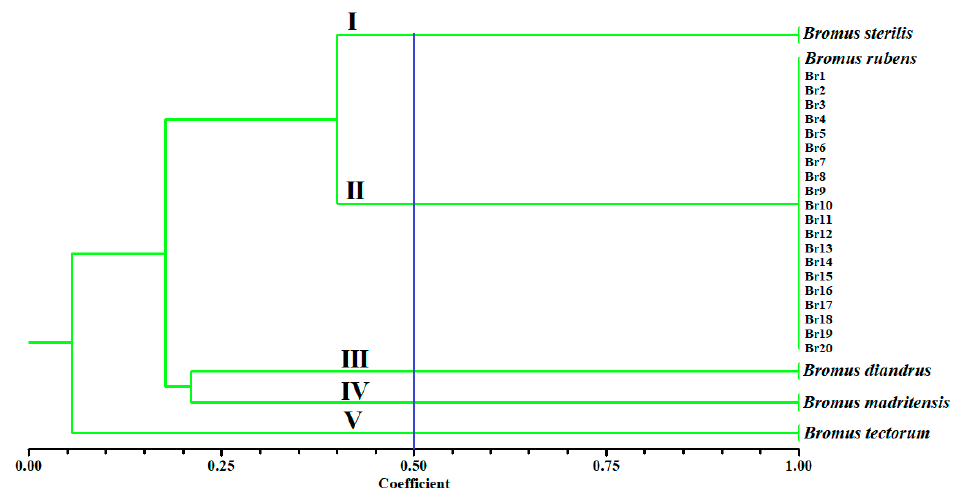
Figure 1. Dendrogram obtained from cluster analysis of 5 Bromus species (24 populations) based on Jaccard’s coefficient of similarity using seven Simple Sequence Repeat (SSR) markers.